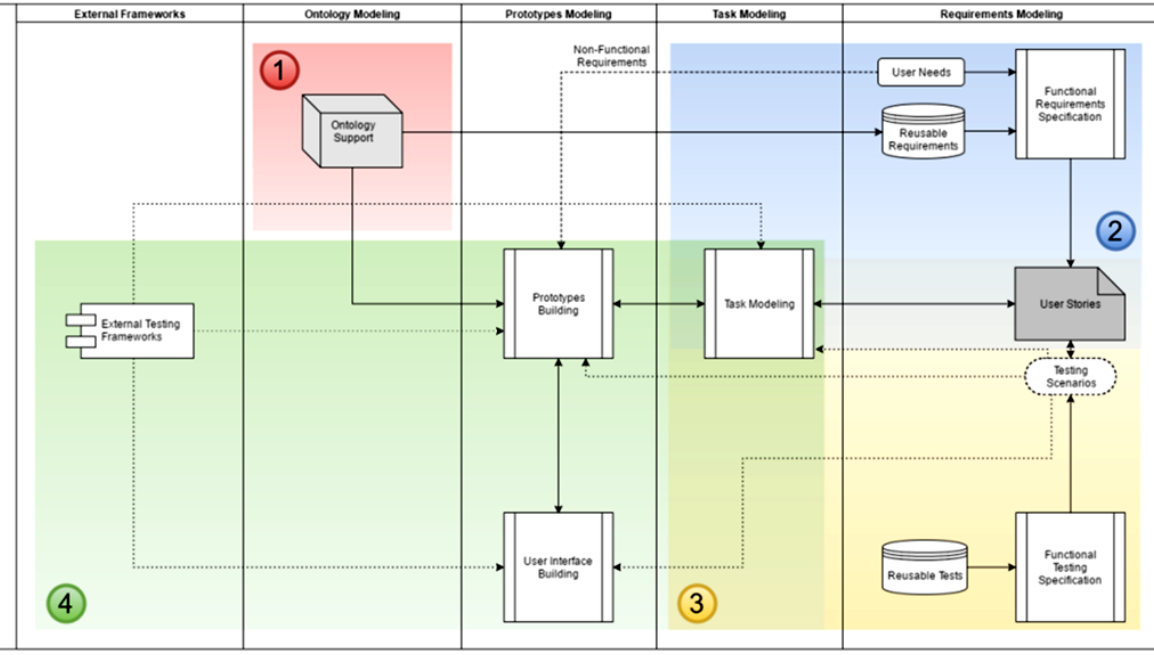
Figure 4. Architectural View of the